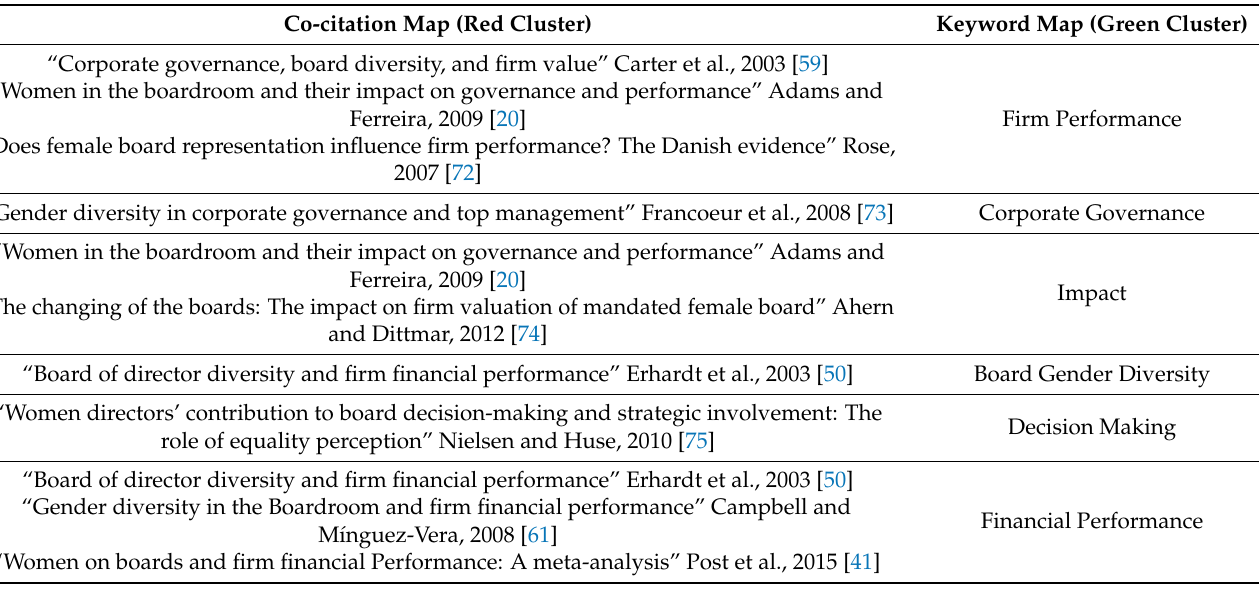
Table 4. Connection between co-citation map and keyword